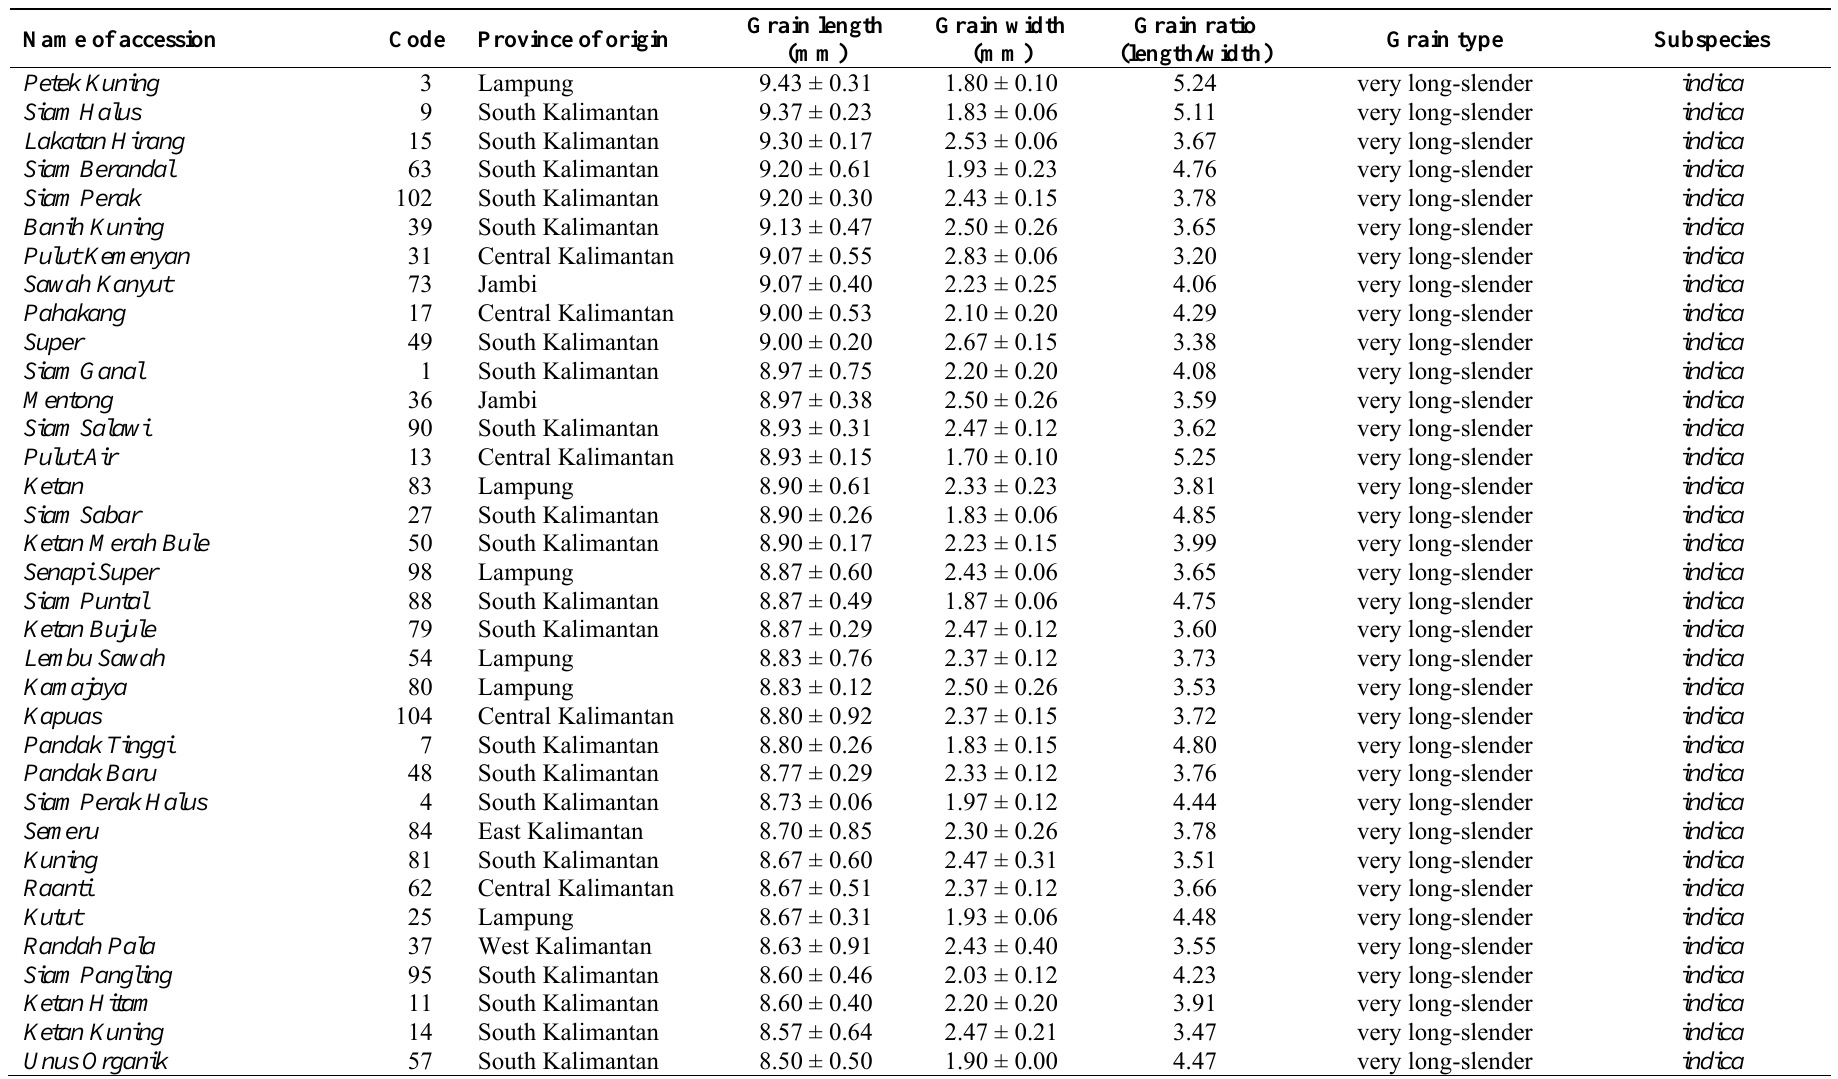
Table A2. Characteristics of Indonesian swamp rice germplasm based on the grain length, width, and ratio, including grain type and